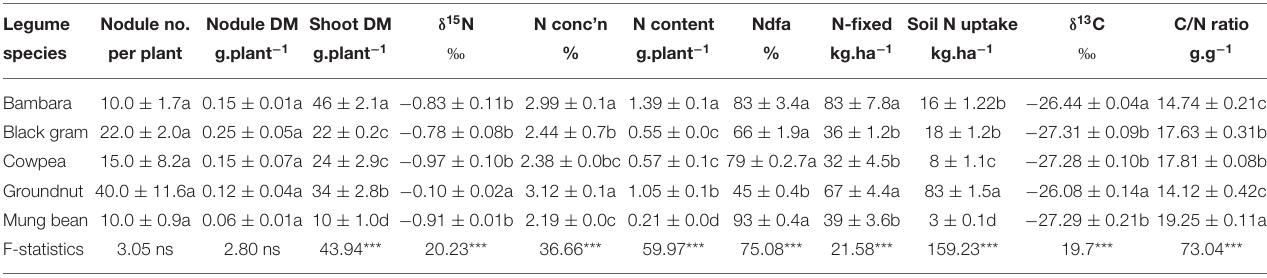
TABLE 3 | Plant growth, root nodulation, symbiotic performance, and soil N uptake of five grain legumes planted in the field at Nelspruit, South Africa, in the 2011/2012 cropping season. Legume Nodule no. Nodule DM Shoot